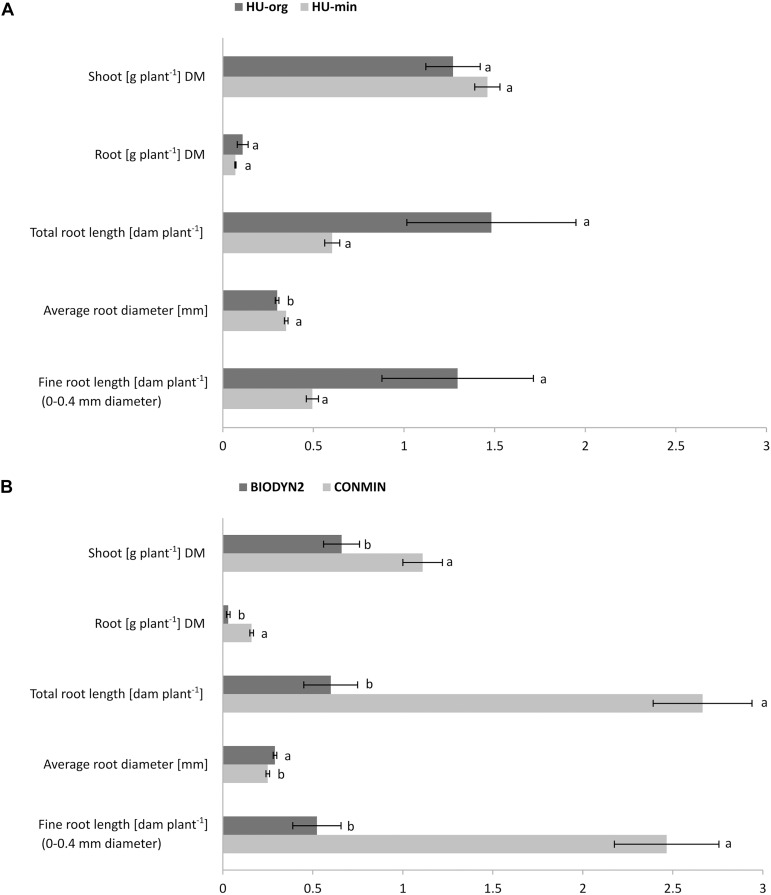
Shoot and root dry biomass (DM) and root morphology of lettuce (cv. Tizian). The plants were grown in minirhizotron culture for nine weeks in soils with long-term organic (HU-org, BIODYN2) or mineral (HU-min, CONMIN) fertilization history. Means ± standard errors of four independent replicates. Different lowercase letters indicate significant differences between organic vs. mineral fertilization tested separately for the sites HUB-LTE (A) and DOK-LTE (B) by one-way ANOVA, Tukey’s HSD pairwise test, p ≤ 0.05.